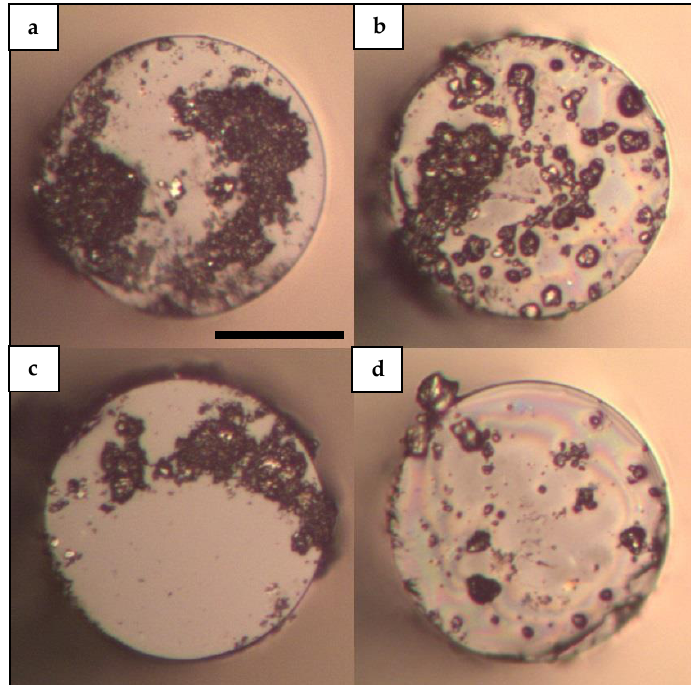
Figure 2. Laser-induced deposition of CNTs onto MMI fiber tip using water-based aqueous solutions: